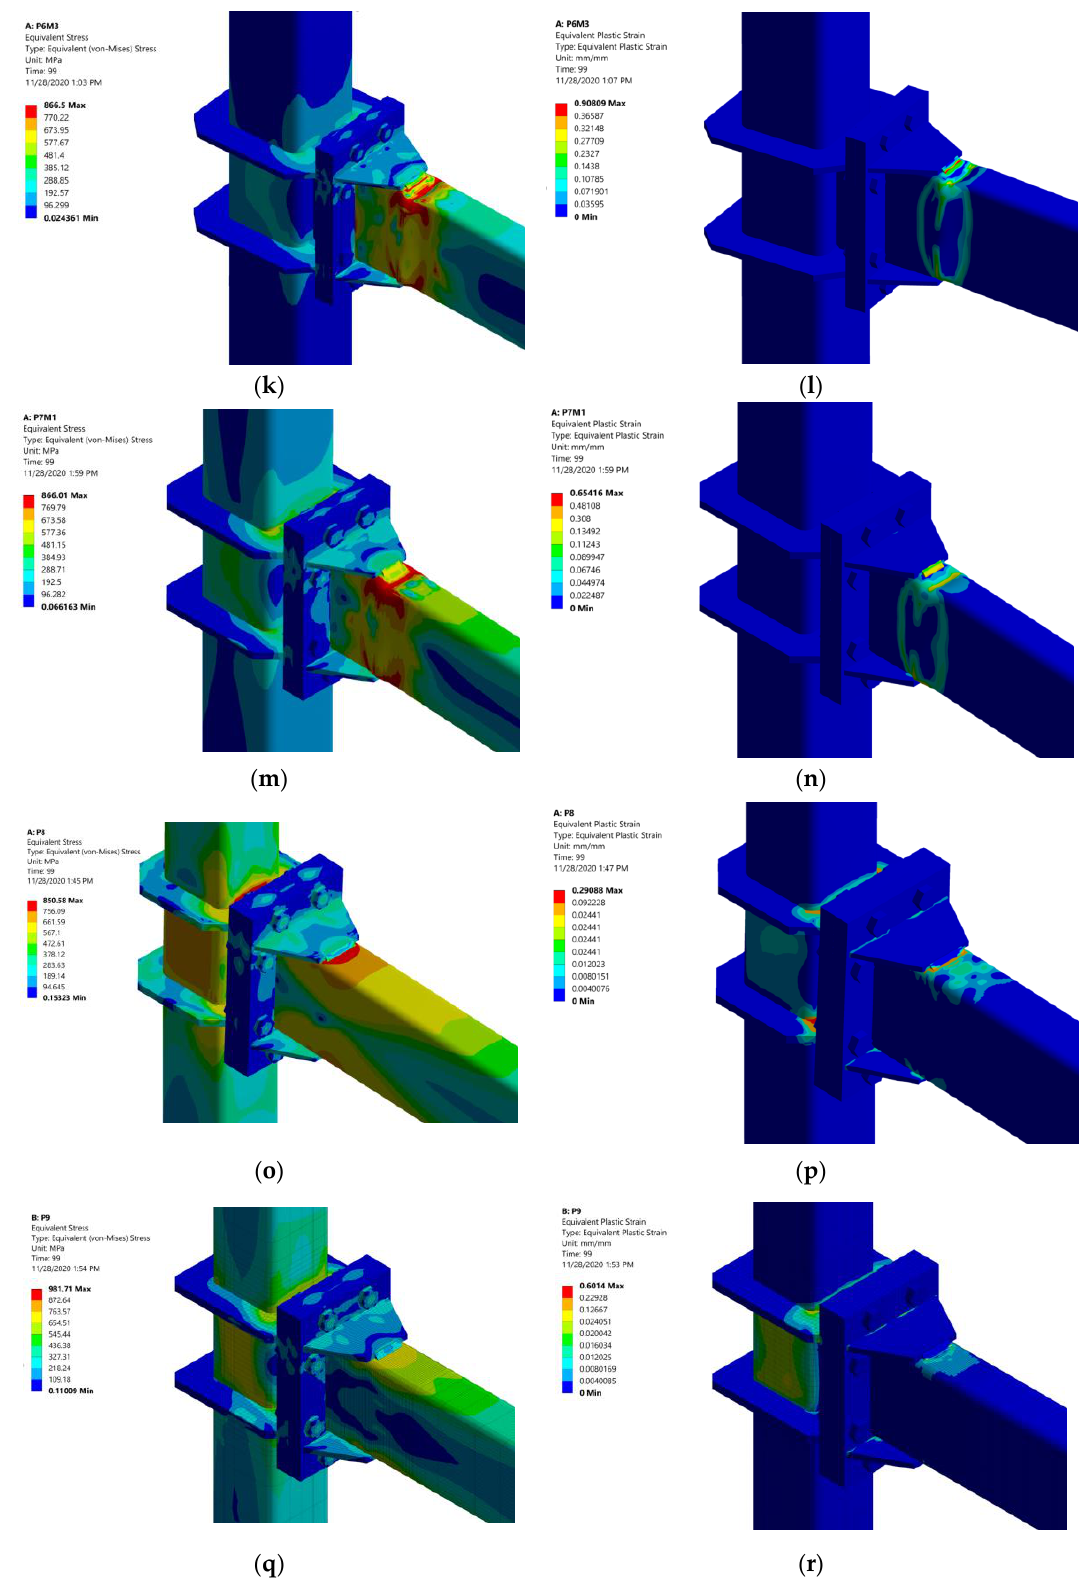
Figure 17. Equivalent stress distribution: ( a ) P1 model, ( c ) P2 model, ( e ) P3 model, ( g ) P4 model, ( i ) P5 model, ( k ) P6 model, ( m ) P7 model, ( o ) P8 model, ( q ) P9 model, and Plastic strain distribution: ( b ) P1 model, ( d ) P2 model, ( f ) P3 model, ( h ) P4 model, ( j ) P5 model, ( l ) P6 model, ( n ) P7 model, ( p ) P8 model, ( r ) P9 model.